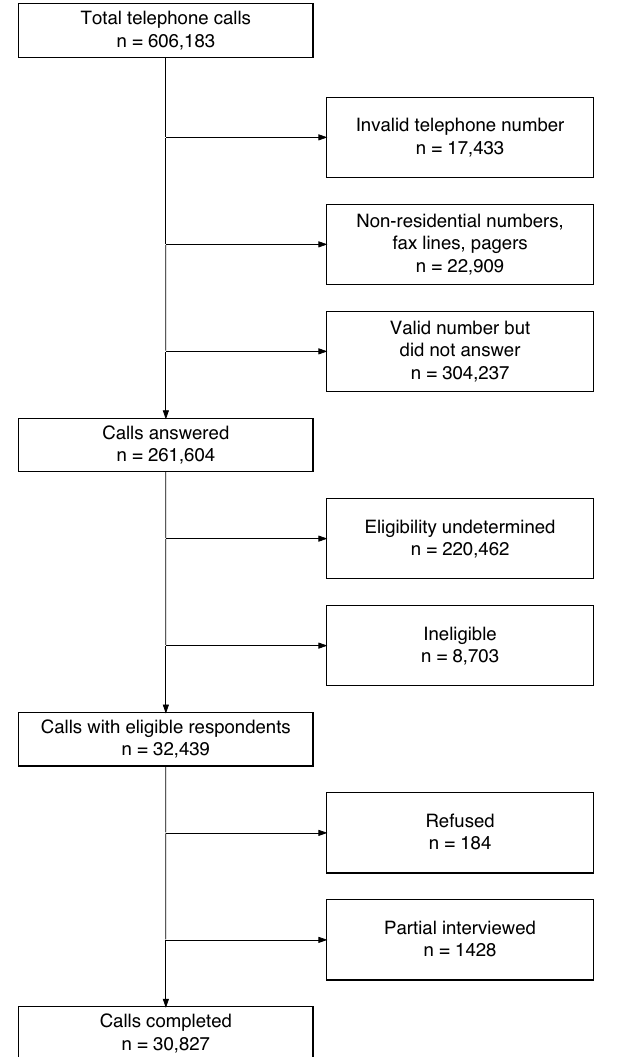
Figure 1. The flow chat of subject recruitment and